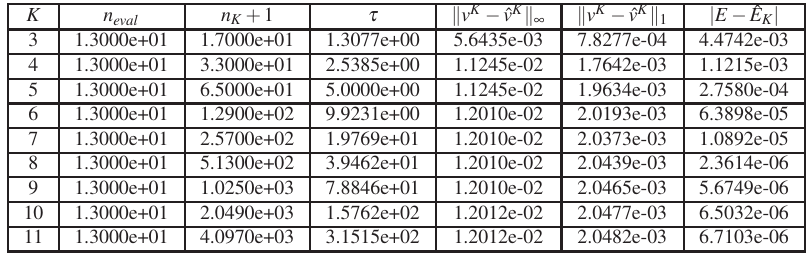
Table 3 Parameters as specified in Table 1 for f 1 , ε = ε k = 10 − 1 and the cubic